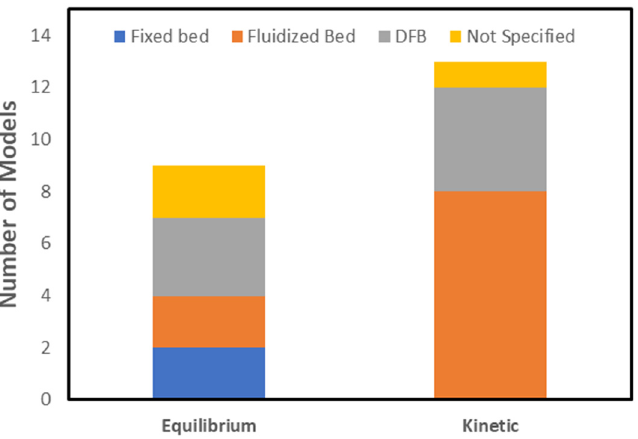
Figure 5. Aspen Plus models published in the past decade for gasification of woody biomass with steam or combined air and steam as the gasification agent.